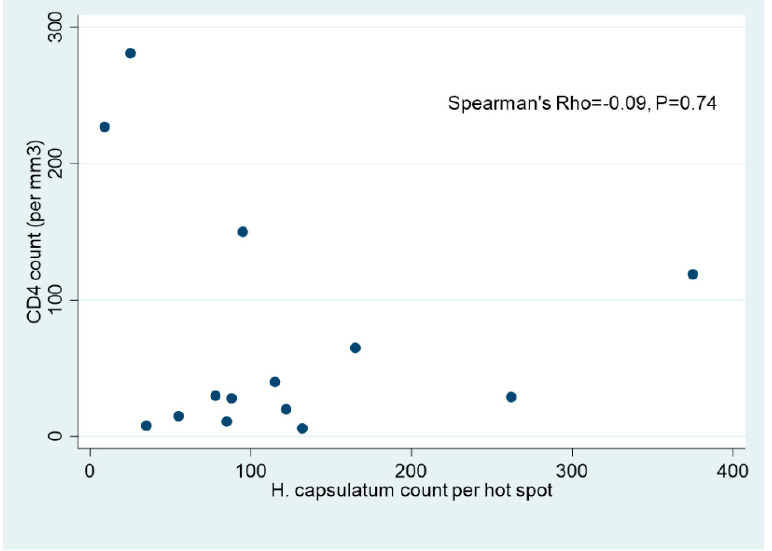
Figure 4. Scatter plot showing a negative but statistically non-significant correlation between the CD4 count/mm 3 and the number of H. capsulatum yeasts per hot spot (×40) among HIV patients ( n = 14) with a Spearman Rho of − 0.09 ( p = 0.74).